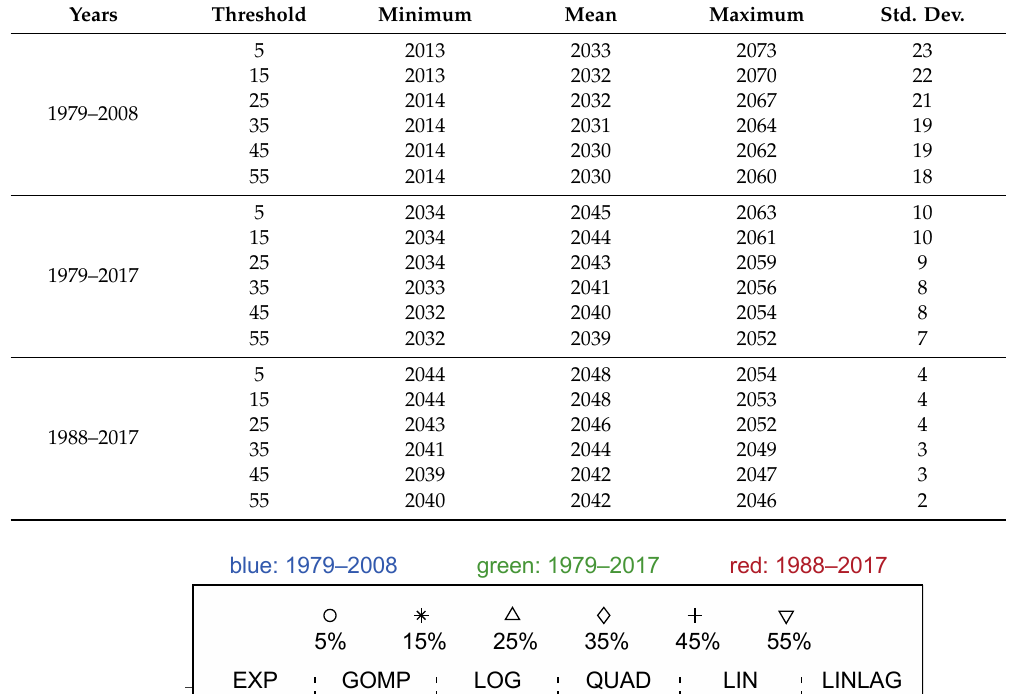
Table 2. Metrics from six model projections of first ice-free Arctic summer year (FIASY). Minimum, mean, and maximum are calculated as described in the methods. The standard deviation is rounded to the nearest whole number.